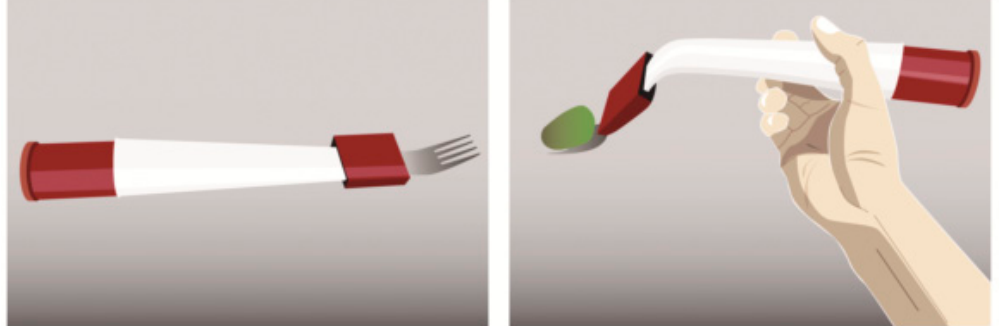
Figure 4. A pneumatic fork that changes its body shape by inflating and deflating through a small pump and valve depending on the detected eating rate [52].